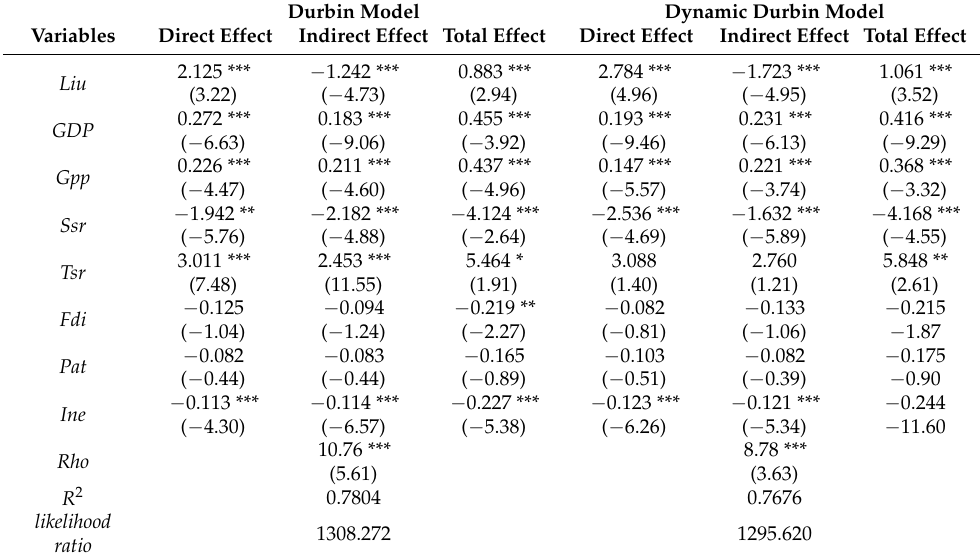
Table 4. Spatial regression results.